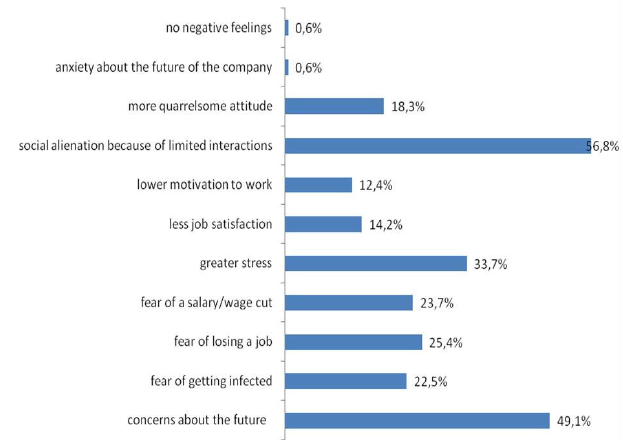
Figure 4. Feelings experienced by employees during the Covid-19 pandemic*. * Respondents could select more than one answer.